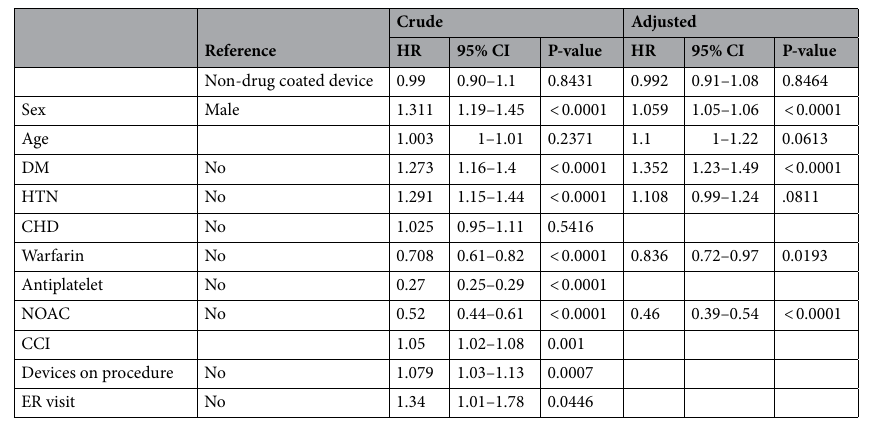
Table 2. Univariate and multivariate analysis of all-cause mortality after propensity score matching. DM diabetes mellitus, HTN hypertension, CHD coronary heart disease, NOAC new oral anticoagulants, CCI Charlson comorbidity index, HR hazard ratio, ER emergency room.